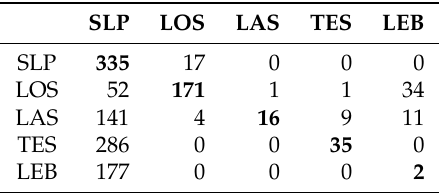
Table 8. Confusion matrix of Subject